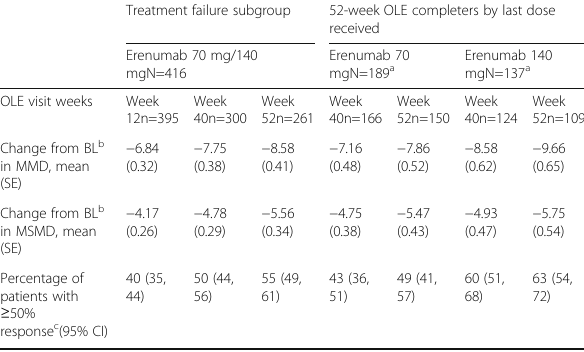
Table 1 (abstract P44). Long-term efficacy with 52-week open-label erenumab treatment after 12-week double-blind treatment in